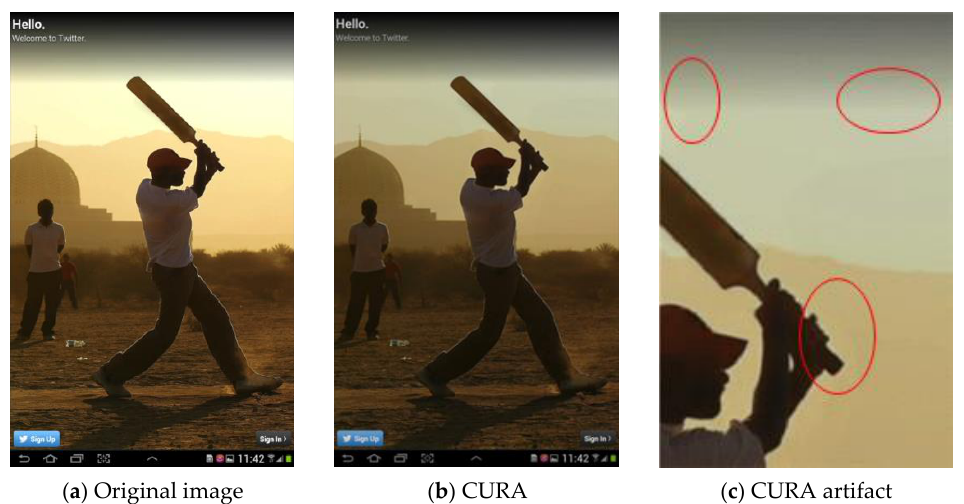
Figure 4. Comparison between an original image and its resultant image from CURA.